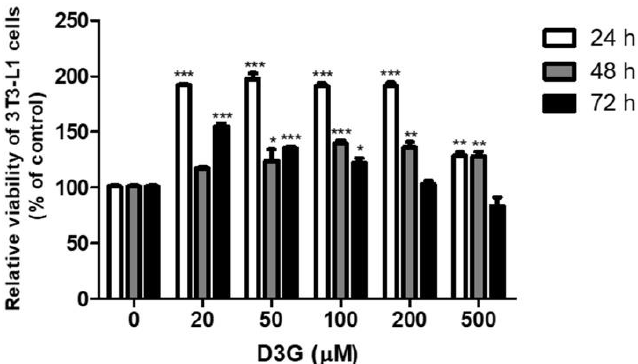
Figure 1. Effect of different delphinidin-3- O - β -glucoside (D3G) concentrations on the viability of 3T3- L1 preadipocytes. * p < 0.05, ** p < 0.01, and *** p < 0.001 vs. 0. All experiments were repeated at least three times and data represents the mean ± SD.